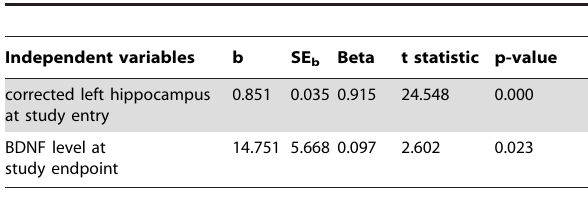
Table 4. Final multiple linear regression model through the origin of corrected left hippocampus at the study endpoint (as dependent variable).